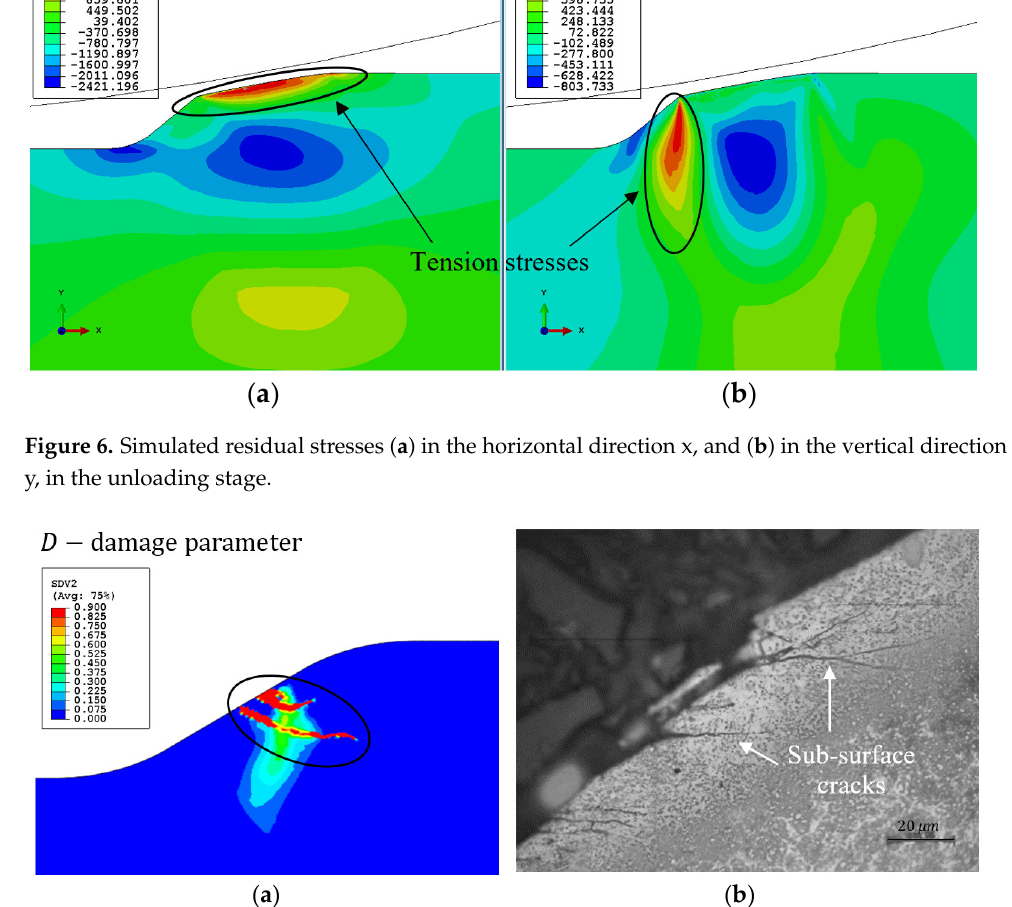
( c ) Figure 8. ( a ) Map of the damage variable, D, represents the crack generation within the spall edge, where the maximum residual stress uses as the effective stress. ( b ) SEM images of the spall edge with surface cracks in front of the spall. ( c ) Close-up image of the front of the spall. 3.3. Simulations of Crack Propagation 3.3.1. The Effect of Impact Location In this section, we study the propagation of the two types of cracks initiated in the previous section. The propagation is controlled by the stresses generated by the impact of the REs. The RE–spall edge interaction has two characteristics: (a) after the first collision of the RE on the spall’s edge, the RE rattles on the raceways several times until it is locked